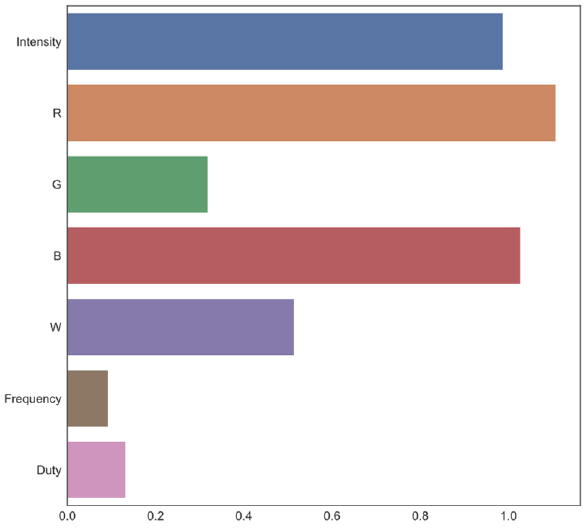
Figure 6. Mutual information evaluated versus the features in the dataset. Table 5. Mutual information gain values for the energy consumption dataset.